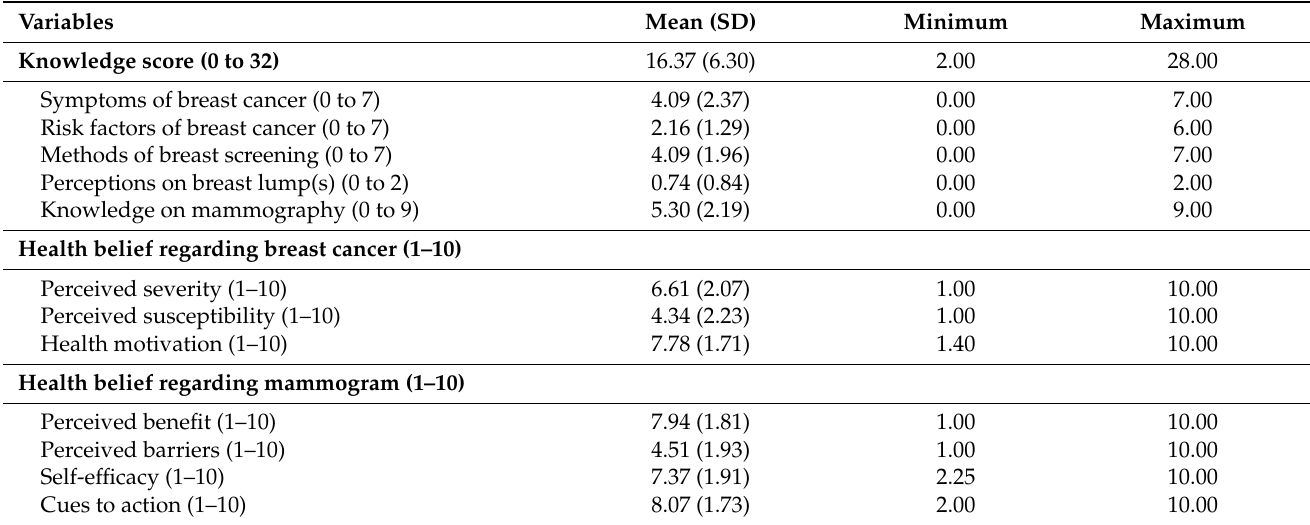
Table 3. The mean scores for knowledge and health beliefs.